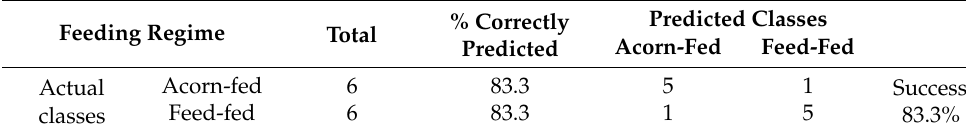
Figure 3. Score plots of LDA calibration models for ( a ) feeding regime and ( b ) breed discrimination using device A. Table 1. Results of feeding regime Raman chemometric classification model with device A.